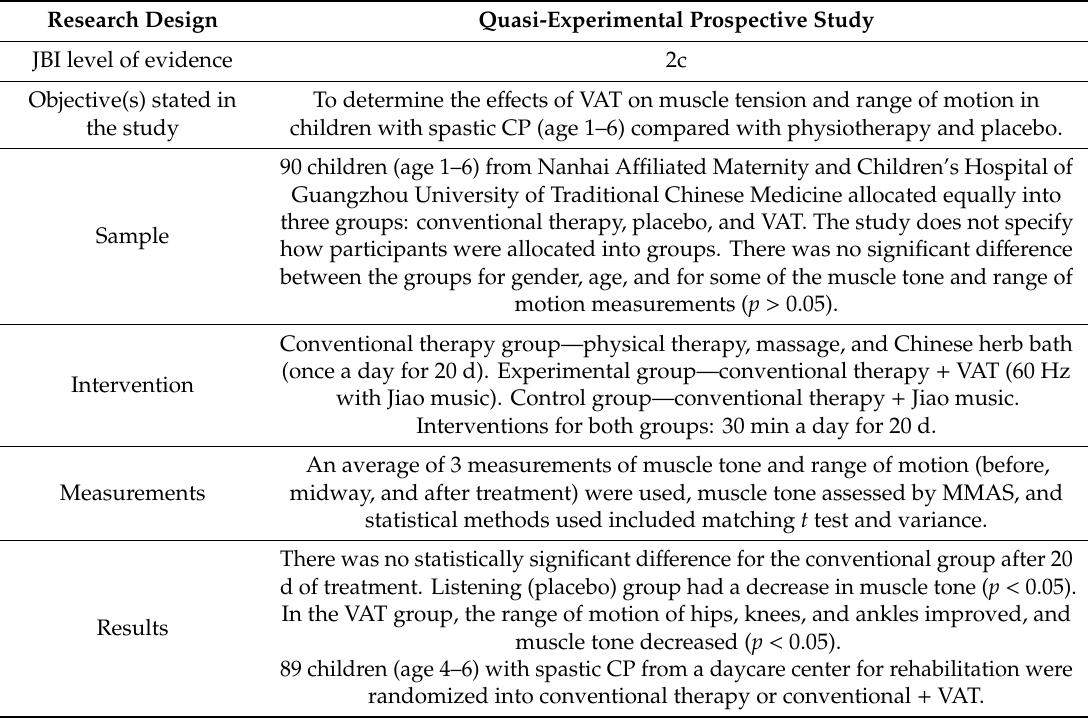
Table 4. Studies on children with CP—Liu, Zhang, and Zhao [40].